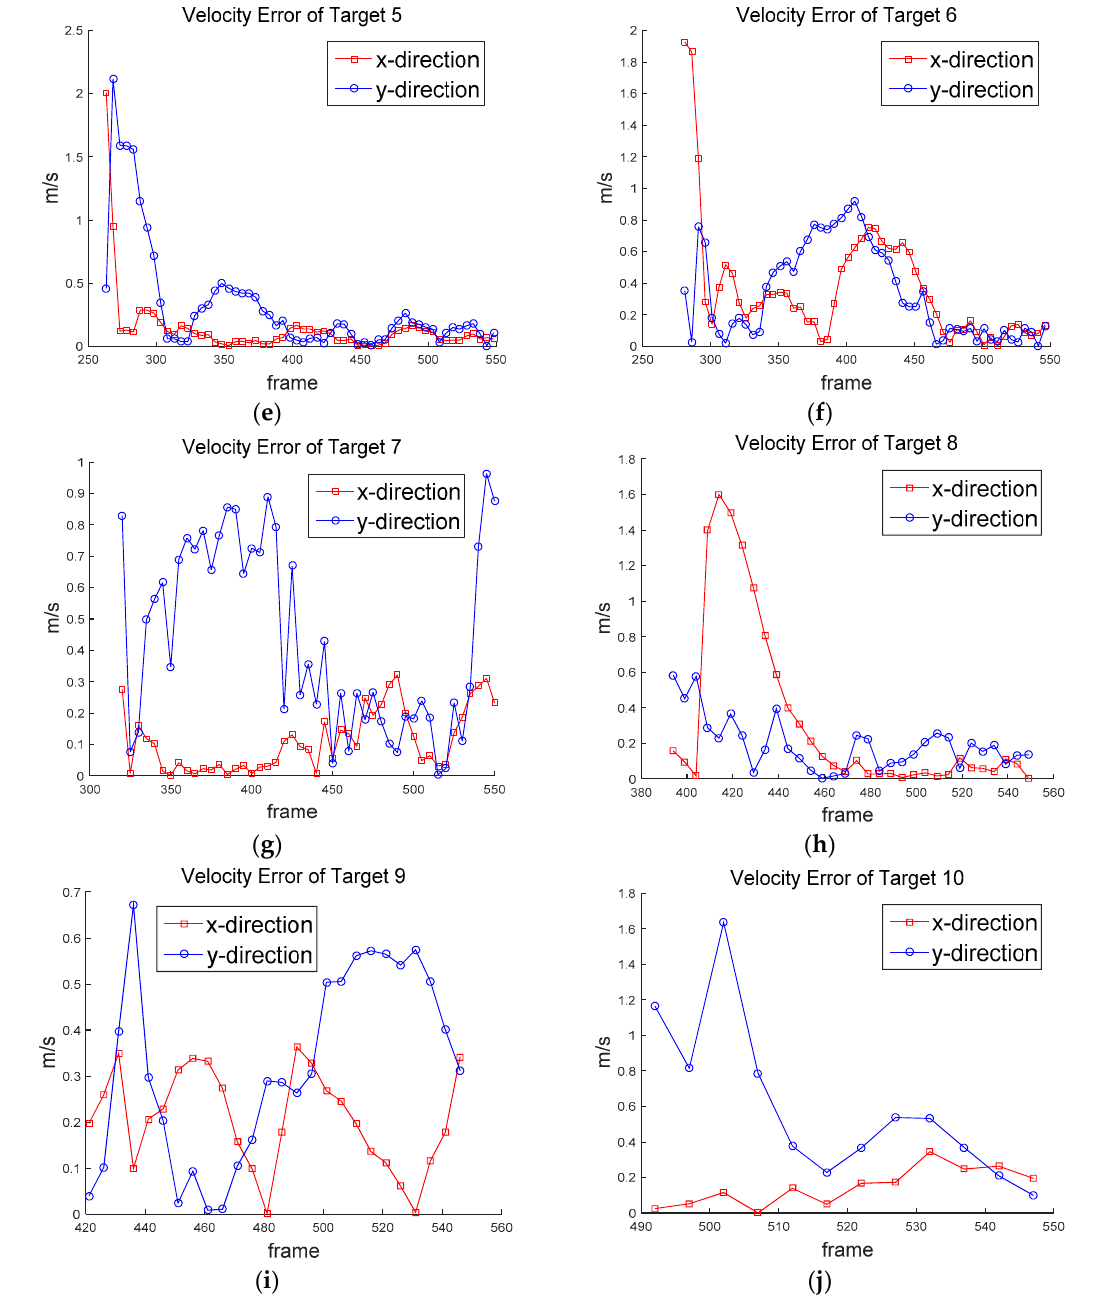
Figure 15. Velocity error of ( a ) Target 1, ( b ) Target 2, ( c ) Target 3, ( d ) Target 4, ( e ) Target 5, ( f ) Target